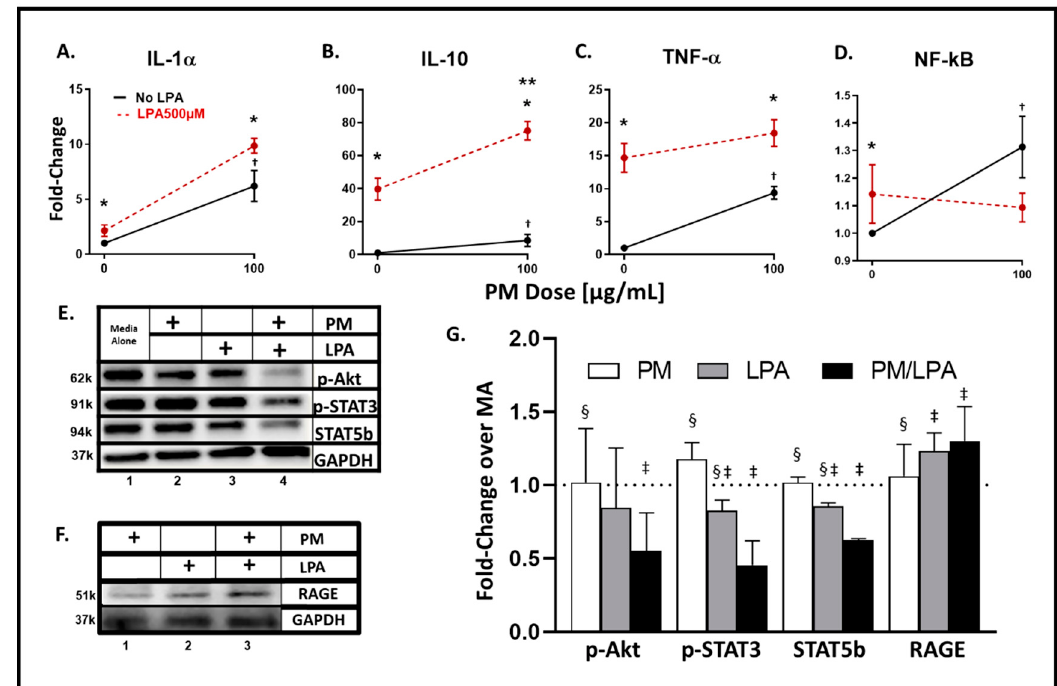
Figure 2. Analyte and transcription factor response to WTC-PM and LPA in RAW264.7 Supernatants were assayed after 24 h of WTC-PM and/or LPA exposure, n = 3. ( A ) IL-1 α , ( B ) IL-10, ( C ) TNF- α , ( D ) NF- κ B. All values reported as mean ± SD of fold change over PBS. Independent LPA exposure is